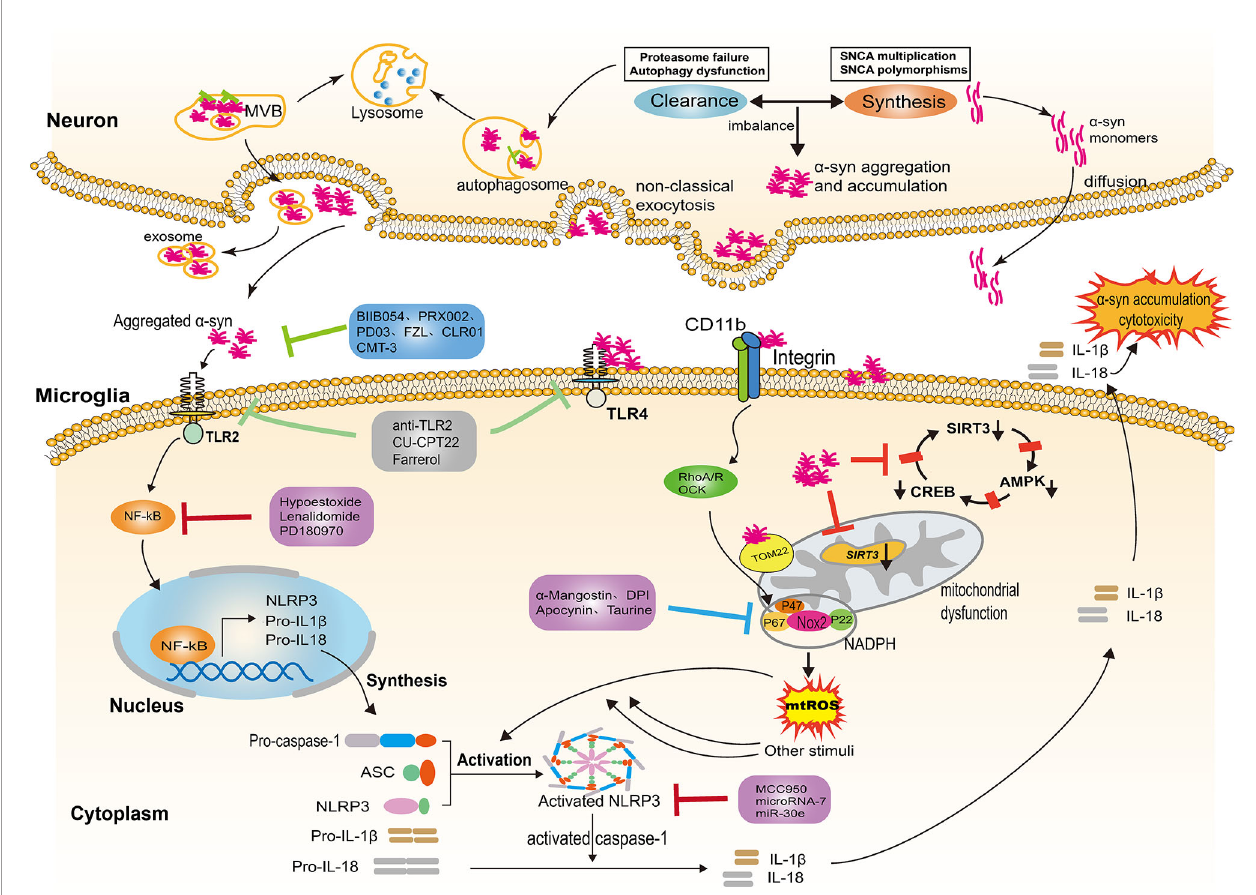
FIGURE 1 | NLRP3 in fl ammasome activation evoked by a -syn aggregates. In Parkinson ’ s disease, the imbalance between the a -syn synthesis and clearance contributes to the aggregation and accumulation of a -syn in the neurons. Neurons release a -syn in distinct ways, including passive and active mechanisms; the type of release depends on the different forms of a -syn. Exosomes are also involved in the release of aggregated a -syn. The a -syn aggregates released into the extracellular space provide the priming signal for the activation of NLRP3 through binding to TLR2, triggering NF- k B-dependent upregulation of NLRP3 and production of pro- in fl ammatory cytokine. In addition, a -syn aggregates impair mitochondrial function following the internalization of a -syn fi brils by microglia, thereby inducing the generation of mtDNA and mtROS. Several molecular mechanisms have been proposed for mitochondrial dysfunction, including the reduction of SIRT3 via the AMPK a - CREB signaling pathway, the blockage of TOM20 and the engagement of CD11b. The aforementioned process provides the second “ activation ” signal for the activation of the NLRP3 in fl ammasome, which induces activated caspase-1-mediated release of mature IL-1 b and IL-18. The in fl ammatory cytokines are capable of augmenting cytotoxicity and a -syn accumulation. Several therapeutic approaches exert a neuroprotection effect by targeting the a -syn/TLRs/NF- k B/NLRP3 process, including immune antibodies, molecular compounds, the repurpose of pre-existing drugs and natural extracts. NLRP3, leucine-rich repeat- and pyrin domain-containing 3; TLRs, toll like receptors; IL-1 b , interleukin-1 b ; IL-18, interleukin-18; NF- k B, nuclear factor kappa light chain enhancer of activated B cells; TOM20, the translocase of the outer membrane receptors; CD11b, the a chain of a non-covalently associated heterodimeric transmembrane receptor integrin a M b 2; ASC, apoptosis-associated speck-like protein; SIRT3, nicotinamide adenine dinucleotide-dependent